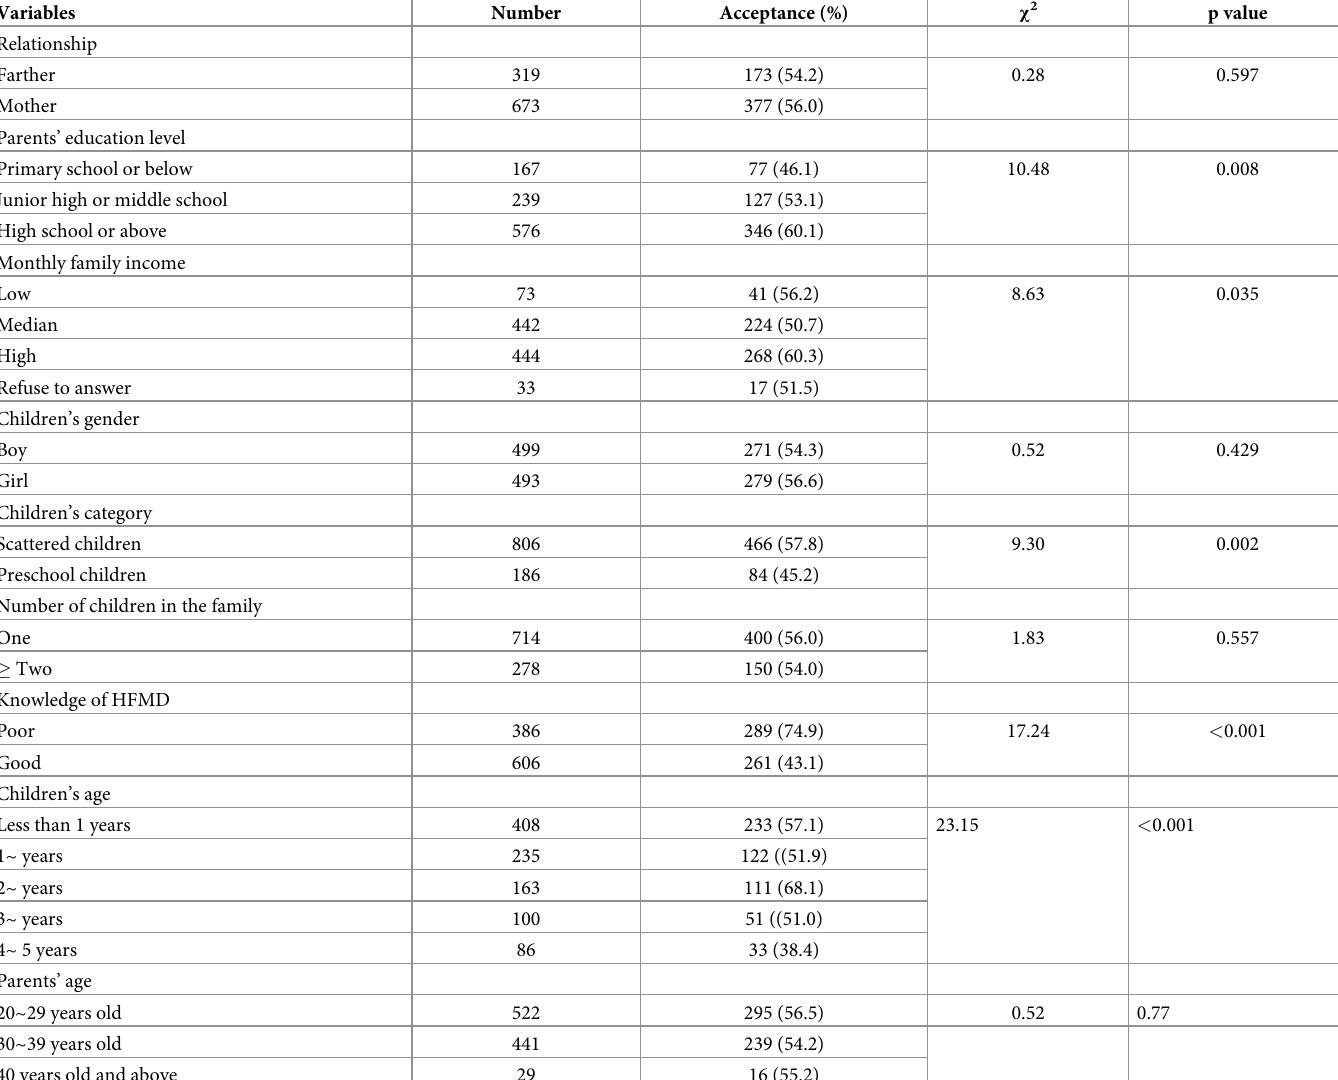
Table 4. The acceptability of EV71 vaccination and uni-variate analysis in study of knowledge of HFMD and acceptability of EV71 vaccine among parents of under- five in Chongqing,